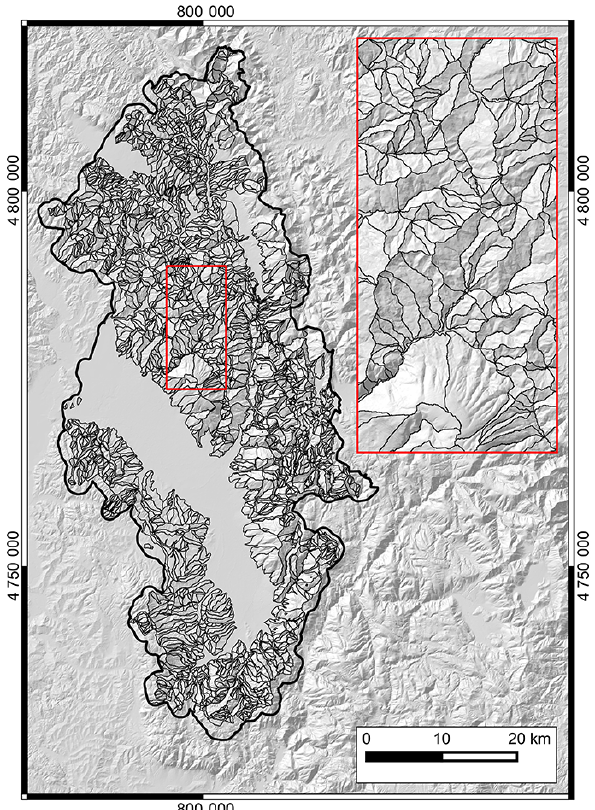
ters selected by our optimization procedure. The values of the pa- rameters are a = 150000m 2 , a = 0.35. The associated LS result is shown in Fig. 10, in the central box, corresponding to the optimal parameters